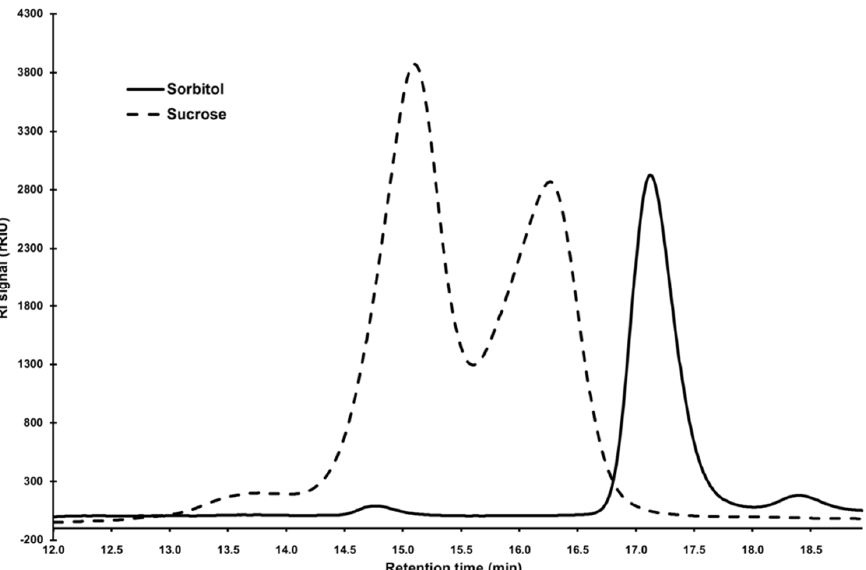
Figure 4. HPLC chromatograms of cellular extracts of pure standards of sorbitol and sucrose, respectively. Sorbitol shows a peak at 17.1 min; sucrose at 15.1 (glucose) and 16.3 min (fructose). RI signal = Refractive Index signal; rRIU = relative Refractive Index Units.